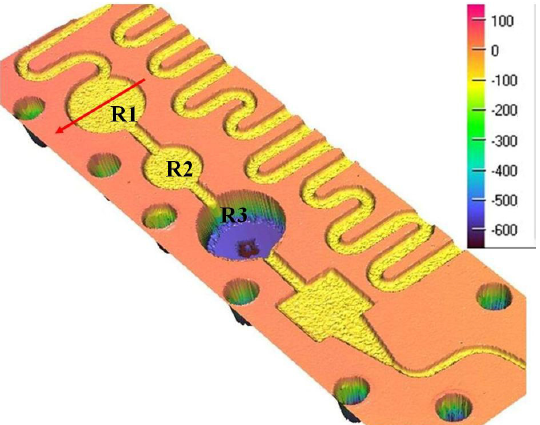
Figure 6. Additional coolant tank area and convergent nozzle, vertical scale in µm.